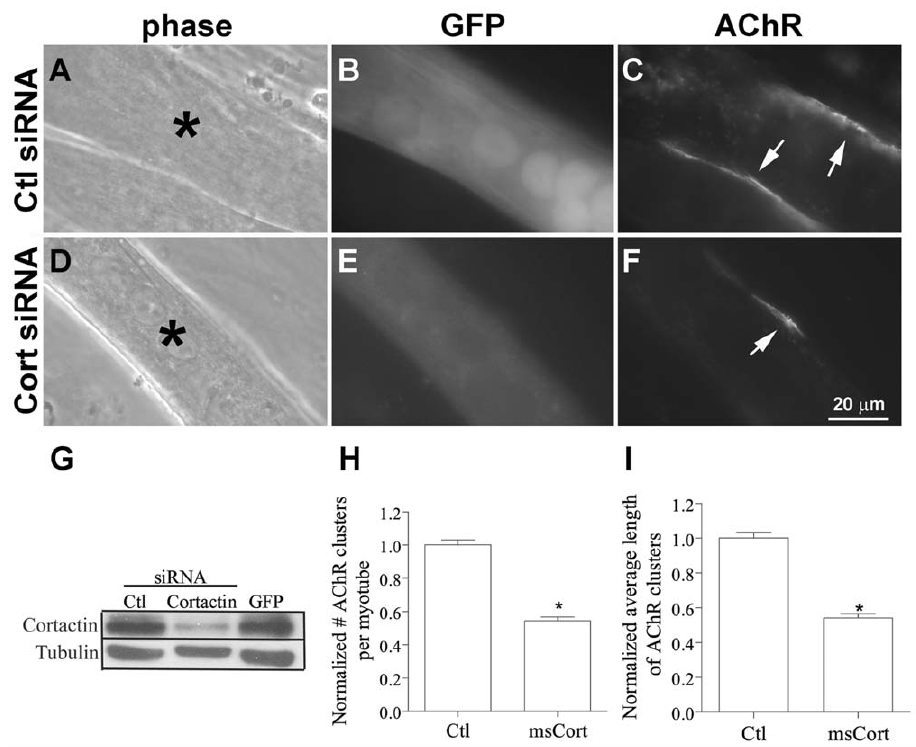
Figure 6. Inhibition of agrin-induced AChR clustering by down-regulation of cortactin expression in myotubes. C2 myotubes generated from myoblasts transfected with control siRNAs (A-C) or a pool of siRNAs directed against mouse cortactin (D-F) (both mixed with a cDNA encoding GFP) were incubated overnight in differentiation medium containing agrin before labeling with R-BTX. Transfected myotubes (A, D; asterisks) were identified by green fluorescence (B, E), and the AChR clusters present on their surface (C, F; arrows) were counted and the lengths of these clusters were measured. G. To demonstrate that siRNAs against cortactin knocked down cortactin expression, in each experiment extracts were prepared from myotubes generated from myoblasts transfected in parallel and maintained under conditions identical to those used for examining agrin-induced AChR clustering. Extracts of cells transfected with GFP cDNA plus control (p120ctn) siRNA (Ctl; left lane), cortactin siRNA (middle lane) or GFP cDNA alone (right lane) were immuno-blotted with antibodies against cortactin (upper blot) or tubulin (lower blot). The cortactin siRNA suppressed the expression of cortactin without affecting unrelated proteins (such as tubulin, which is also shown here to demonstrate equal protein loading), and cortactin’s expression was not affected by control siRNAs or by transfection procedures (where only GFP cDNA was used). From four transfection experiments AChR cluster data from control (Ctl) and mouse cortactin (msCort) siRNA-transfected myotubes were pooled and normalized relative to those obtained from cells transfected with the control siRNA. These results showed that agrin-induced AChR cluster numbers (H) and lengths (I) were significantly lower in myotubes expressing reduced levels of endogenous cortactin compared to those expressing normal levels of cortactin. Mean and SEM values are shown, *P ,